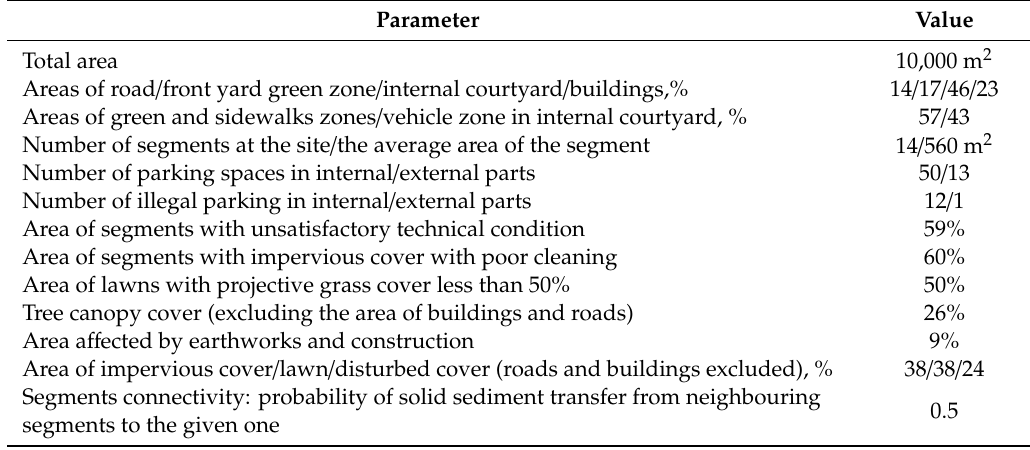
Table 2. Characteristics of the typical EURL in a large Russian